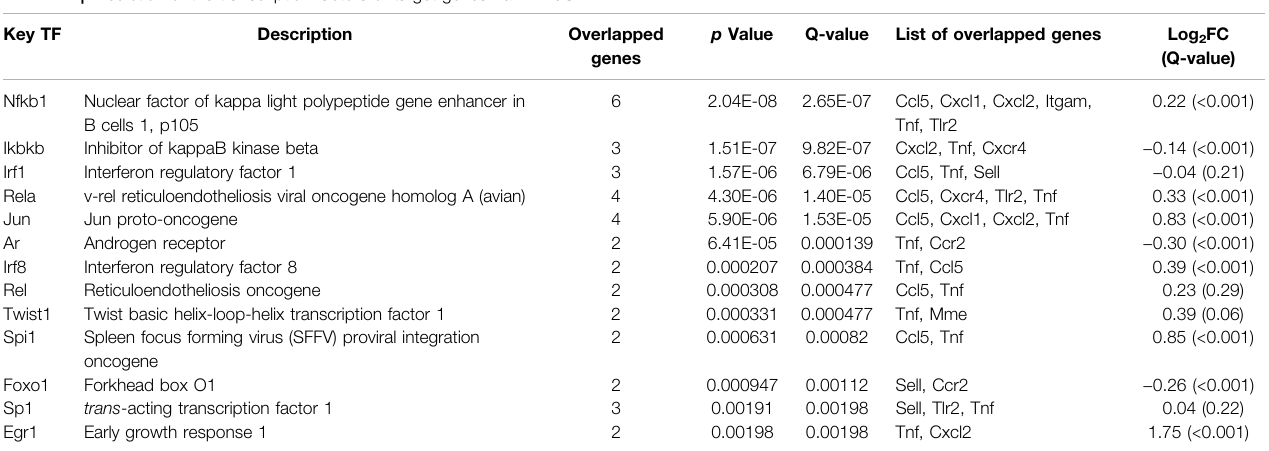
TABLE 1 | Prediction of the transcription factors of target genes via